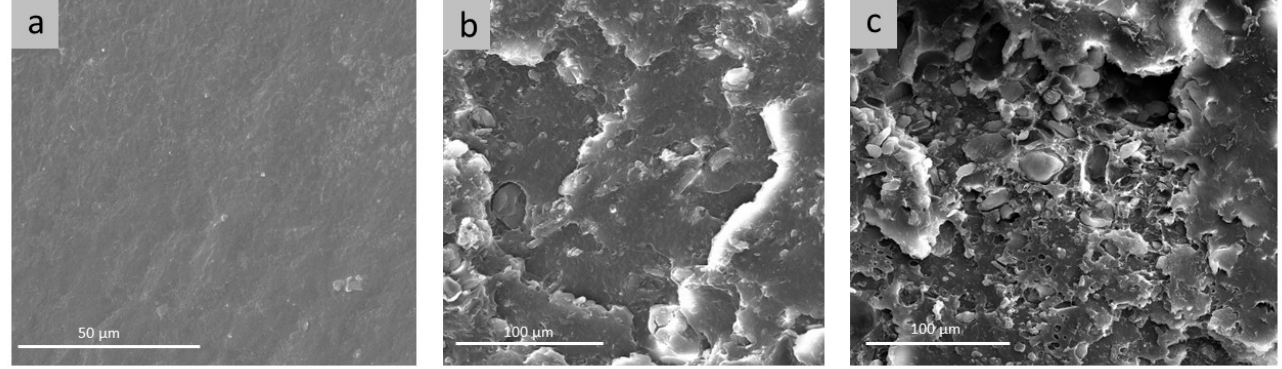
Figure 1. SEM micrographs of PE ( a ), PE/20CD ( b ), and PE/20CD-lim ( c